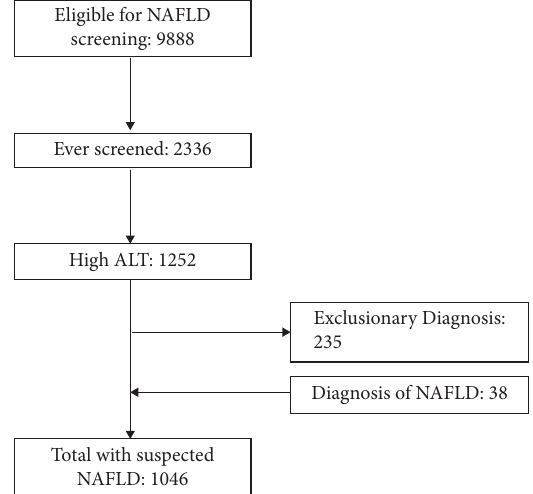
Figure 2: Identifcation of children with suspected NAFLD.